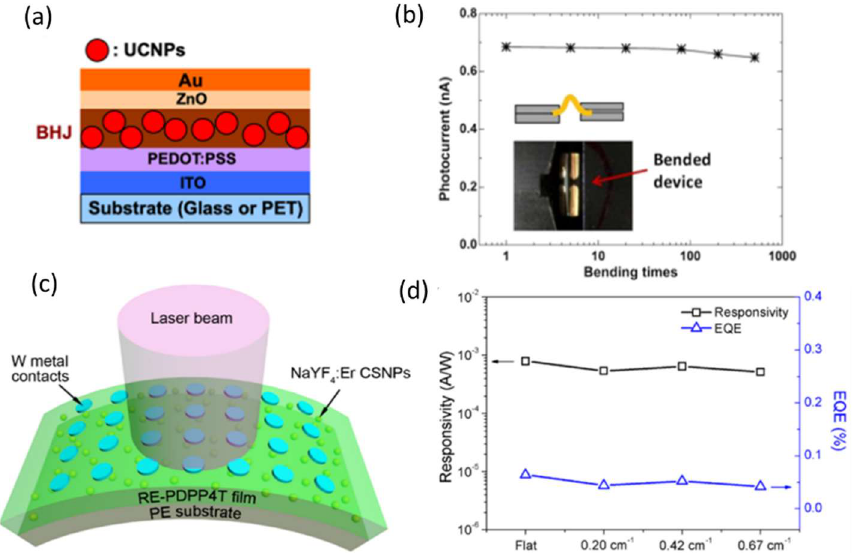
Figure 8. ( a ) Schematic describing the hybrid BHJ (DPPTT-T/PC70BM)/UCNP PD device architecture, ( b ) photocurrent of this device measured after a certain number of bending cycles under the illumination of a λ = 1.5 µm laser at 96 µW reprinted with permission from [140] ©2019 ACS Publications . , ( c ) schematic of the planar PD architecture in which the RE−SCP composite rests on a flexible PE substrate, and ( d ) calculated R and EQE at different bending configurations show an unchanged detection response under varying degrees of mechanical stress reprinted with permission from [144] ©2018 ACS Publications .